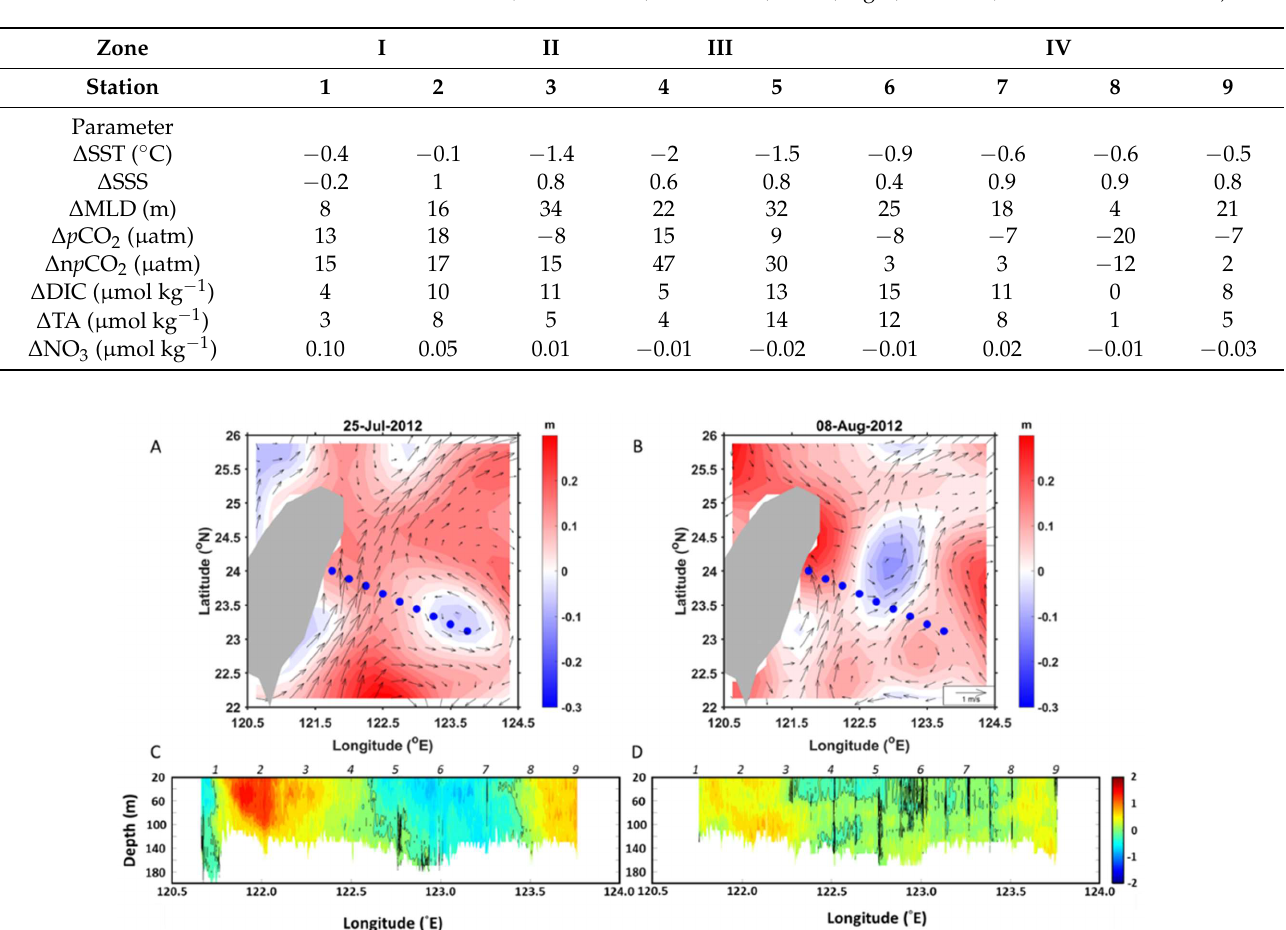
Table 1. Summary of the difference in surface seawater temperature ( ∆ SST), surface seawater salinity ( ∆ SSS), mixed-layer depth ( ∆ MLD), p CO 2 ( ∆ p CO 2 ), temperature-normalized n p CO 2 ( ∆ n p CO 2 ), as well as average dissolved inorganic carbon ( ∆ DIC), TA ( ∆ TA), and nitrate ( ∆ NO 3 ) in the mixed layer before and after the typhoon passage at the nine hydrological stations, which were grouped into four subzones based on the p CO 2 variations (Zone I, stations one and two; Zone II, station three; Zone III, stations four and five; and Zone IV, stations six, seven, eight, and nine; see text for the details).